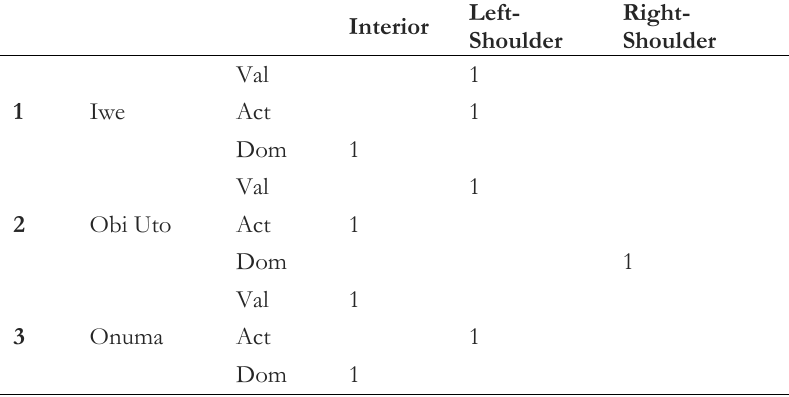
Table 11. Sample result of the nature of the FOU for each emotion